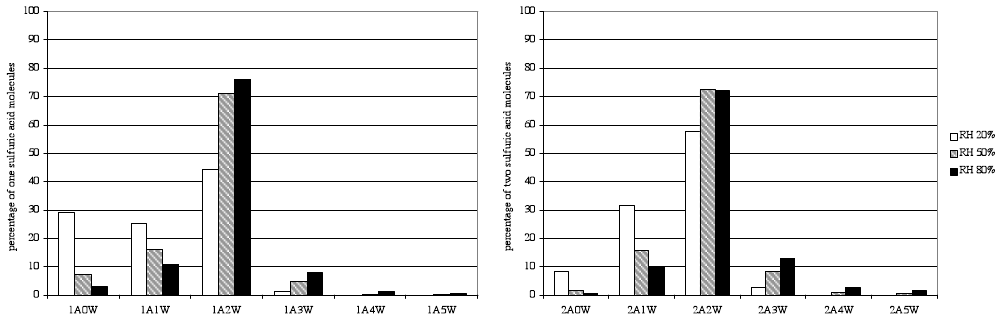
Fig. 8. Hydrate distributions of clusters with one sulfuric acid molecule (left) and clusters with two sulfuric acid molecules (right) at three different relative humidities. 1AxW ≡ H 2 SO 4 · ( H 2 O ) x and 2AxW ≡ ( H 2 SO 4 ) 2 · ( H 2 O ) x . In all cases T = 298 . 15K.